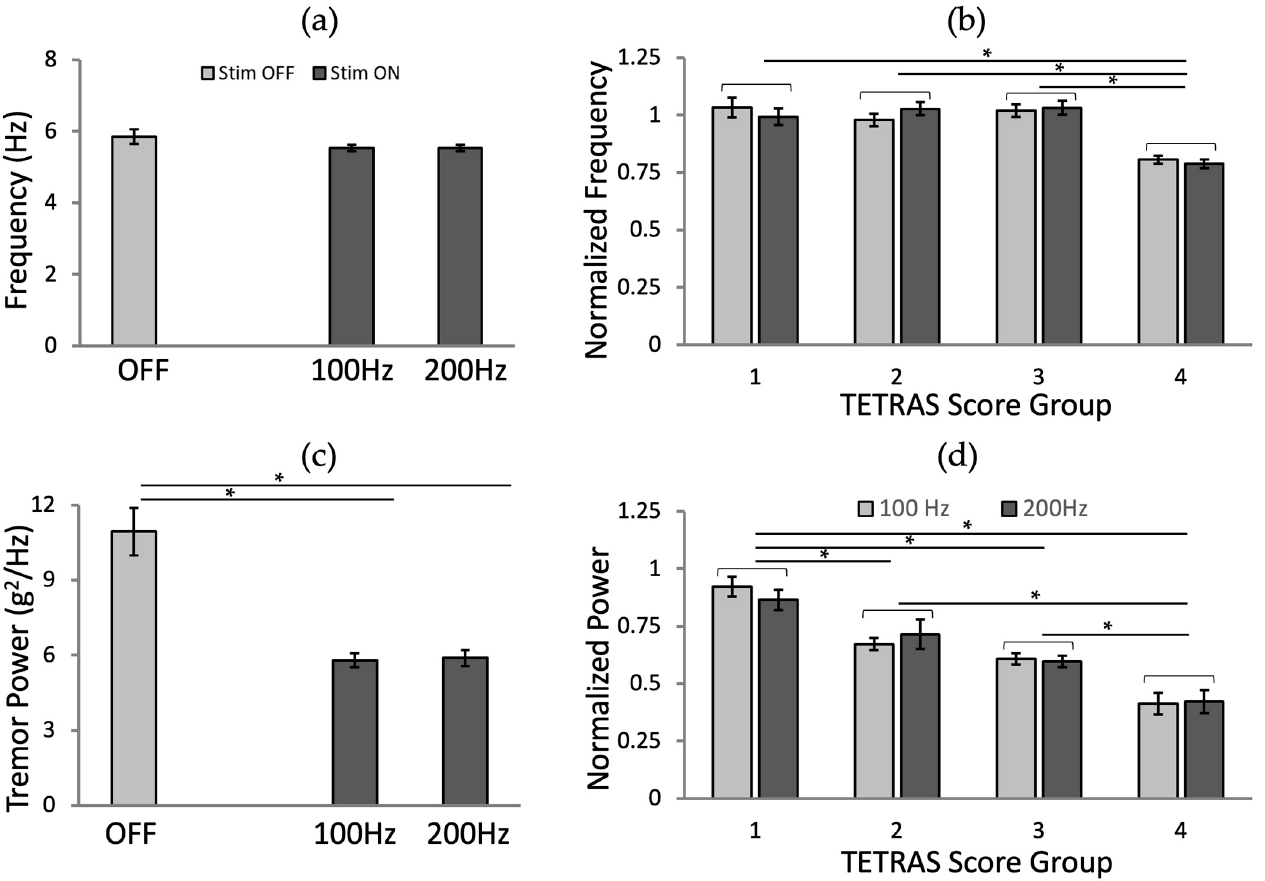
Figure 8. The effects of the stimulation frequency (100 and 200 Hz) by tremor metrics: ( a ) Tremor frequency and ( c ) power. The normalized tremor metrics for the different frequency by the TETRAS score groups: ( b ) Tremor frequency and ( d ) power. The error bars represent the standard errors. *: p < 0.05.